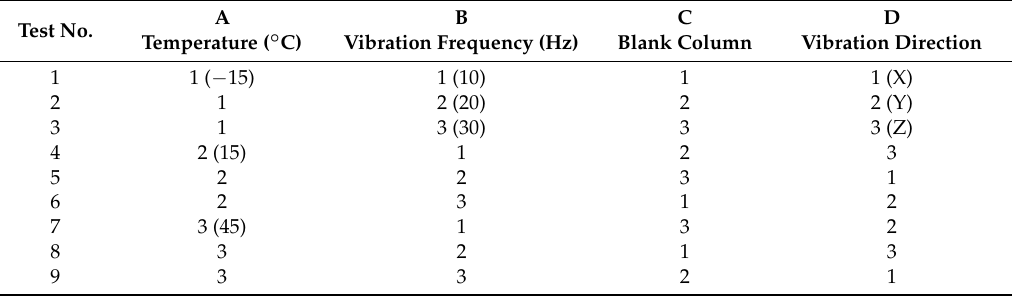
Table 12. The orthogonal table plans.